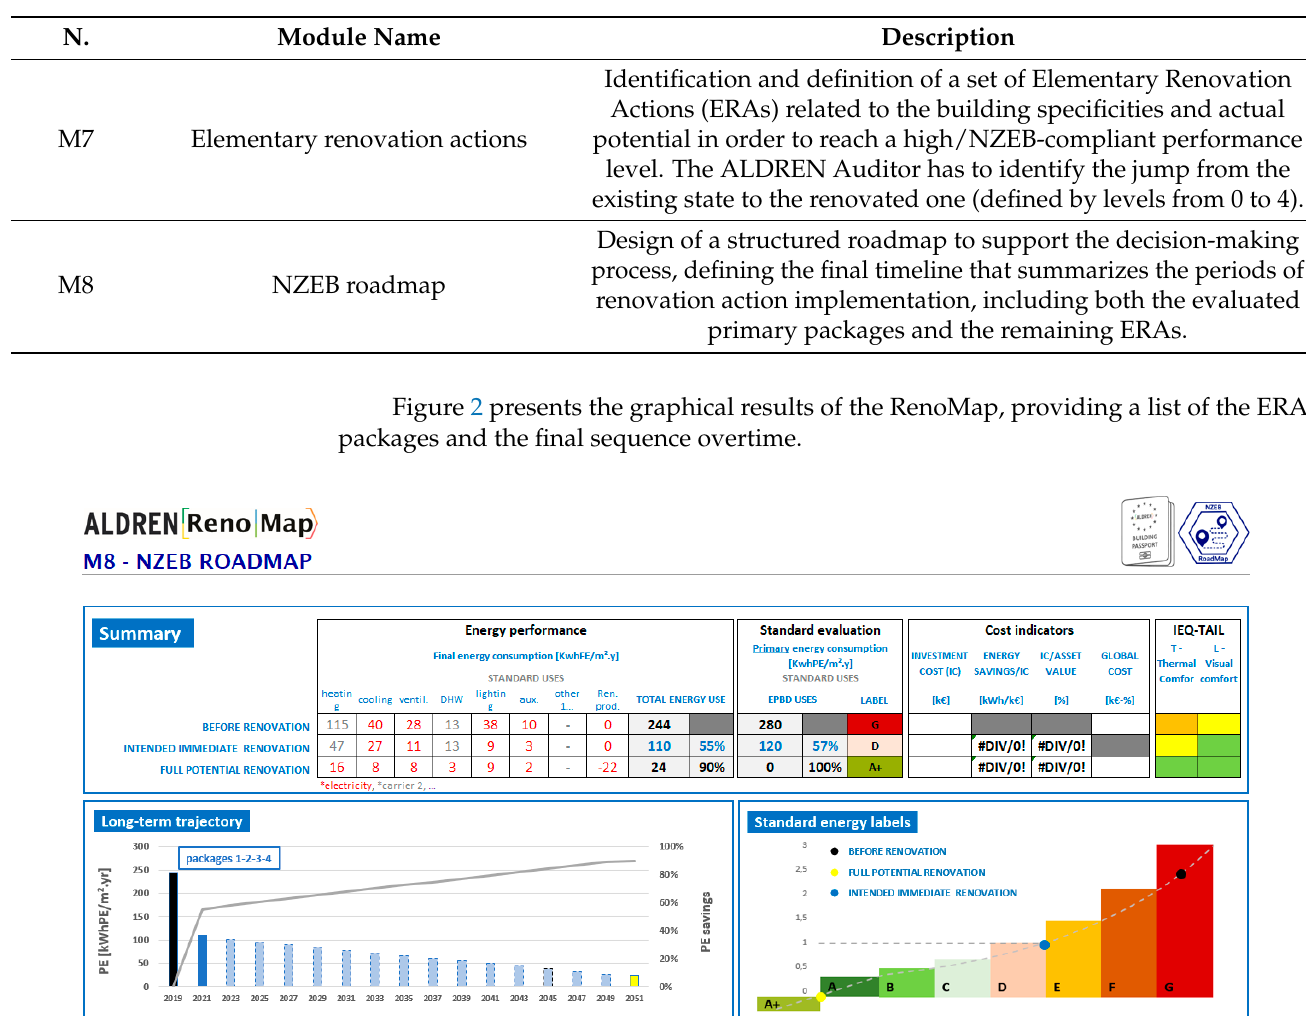
Table 4. Definition of the two ALDREN RenoMap modules.